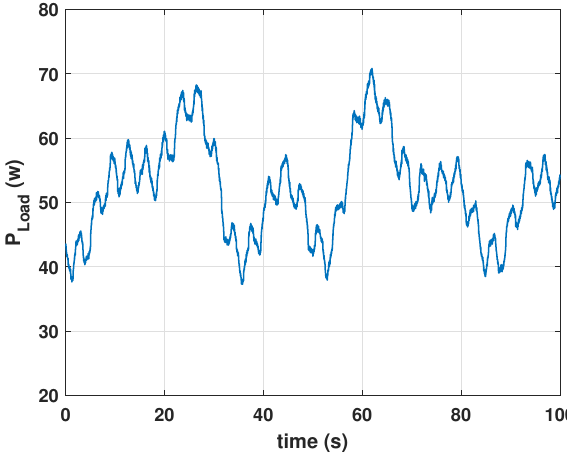
Figure 20. Output power of the DC load.